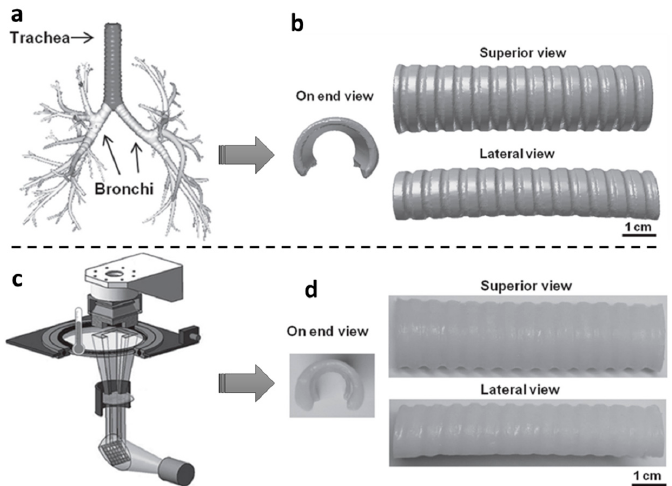
Figure 11. Developing process a shape memory airway stent, a tracheal stent used to alleviate breathing problems. ( a ) A digital model of a middle-aged male’s tracheobronchial tree obtained from MRI scan [146]. ( b ). A CAD model of the structure [146] ( c ) Using a specially designed heating bath that is heated over the melting point of the resin, the digital models are printed on a commercial SLA printer [147]. ( d ) The permanent shape of printed tracheal stent [146].